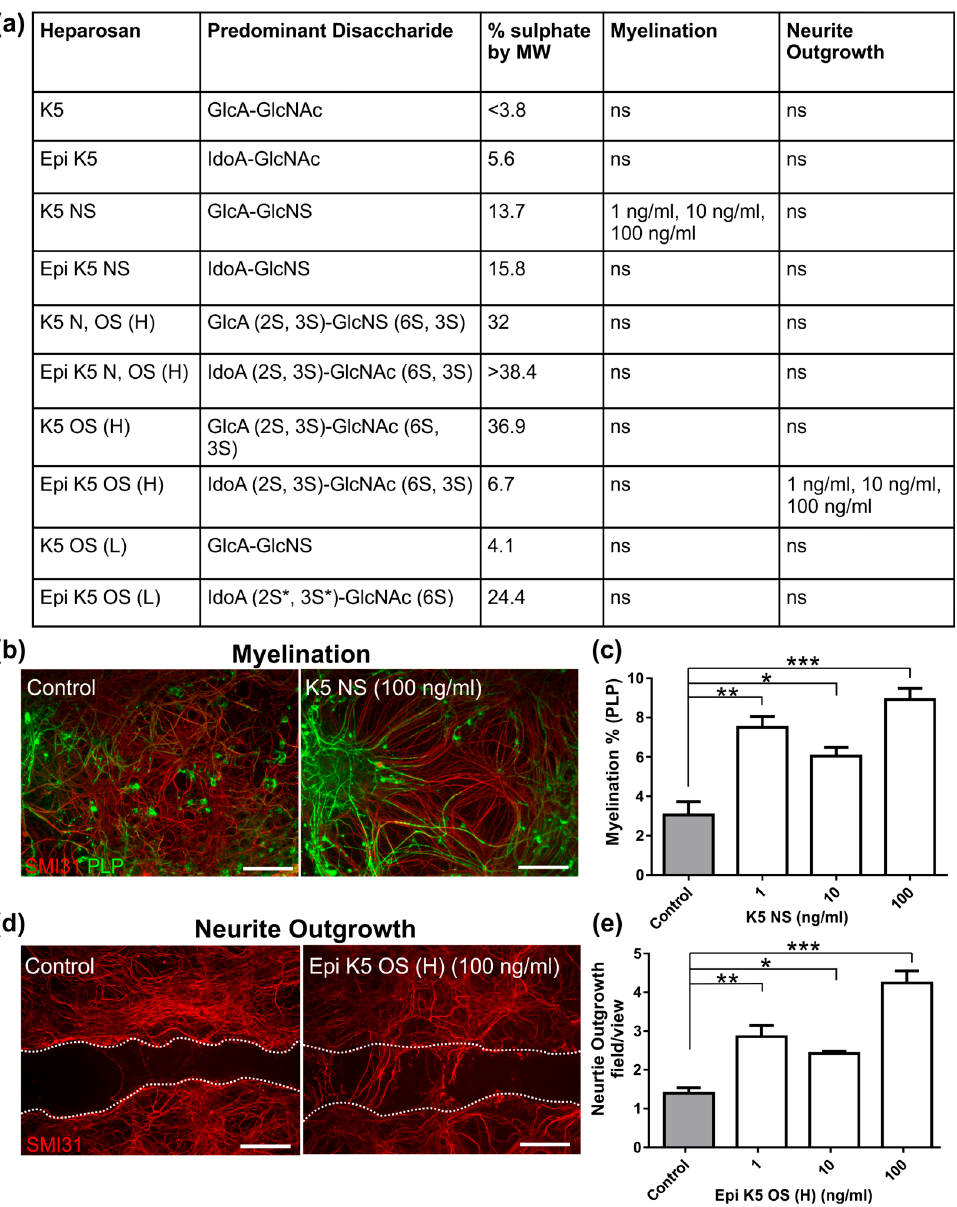
Figure 2. Heparosan screen using MC-Inj. ( a ) Table of the panel of heparosans used to treat MC-Inj detailing the predominant disaccharide, the % sulphate by MW (based on modified Terho method) and concentrations at which any significant increases were detected for each parameter tested. ( b ) Representative images of MC-Inj at 30 DIV showing areas adjacent to the lesion in control and after treatment with K5 NS at 100 ng/mL (SMI31 stains neurites in red, PLP stains myelin in green). ( c ) Quantification of K5 NS treatment shows that it significantly promotes myelination adjacent to the lesion at 1 ng/mL, 10 ng/mL, and 100 ng/mL compared to the non-treated injured control cultures (one-way ANOVA with Dunnett multiple comparison, ** p = 0.0015, * p = 0.015 *** p = 0.0003, respectively). ( d ) Representative images of MC-Inj lesion at 30 DIV showing the non-treated control and following treatment with Epi K5 OS at 100 ng/ml (SMI31 stains neurites in red). Injury site demarcated with white dotted lines. ( e ) Quantification of Epi K5 OS (H) treatment at 1 ng/mL, 10 ng/mL and 100 ng/mL showed significant increases in neurite outgrowth compared to the non-treated injured control cultures at all concentrations (one-way ANOVA with Dunnett multiple comparison, ** p = 0.0048, * p = 0.030 and *** p = 0.0001, respectively); ns, non-significant, Scale bars represent 50 µm in all images, error bars + SEM (all heparosan treatments n = 3; technical replicates n = 3).